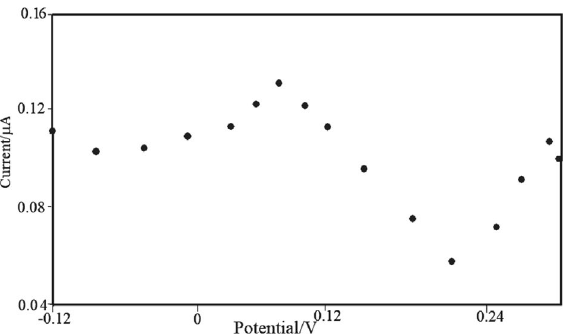
Figure 8. Variation of applied potential with Au/PANI/Pt electrode towards 10 mM glucose in 0.1 M